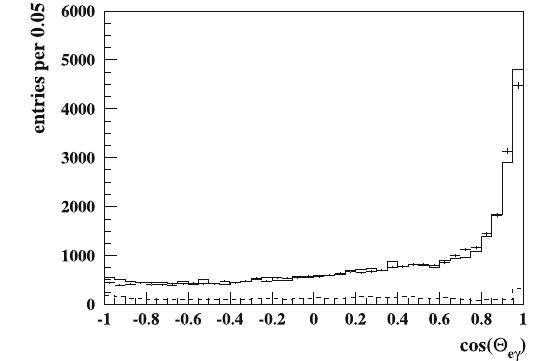
Fig. 5 The distribution of the events over cos (cid:5) ∗ e γ . Points with errors are the real data, histogram – MC signal plus background, MC back- ground - dotted line histogram